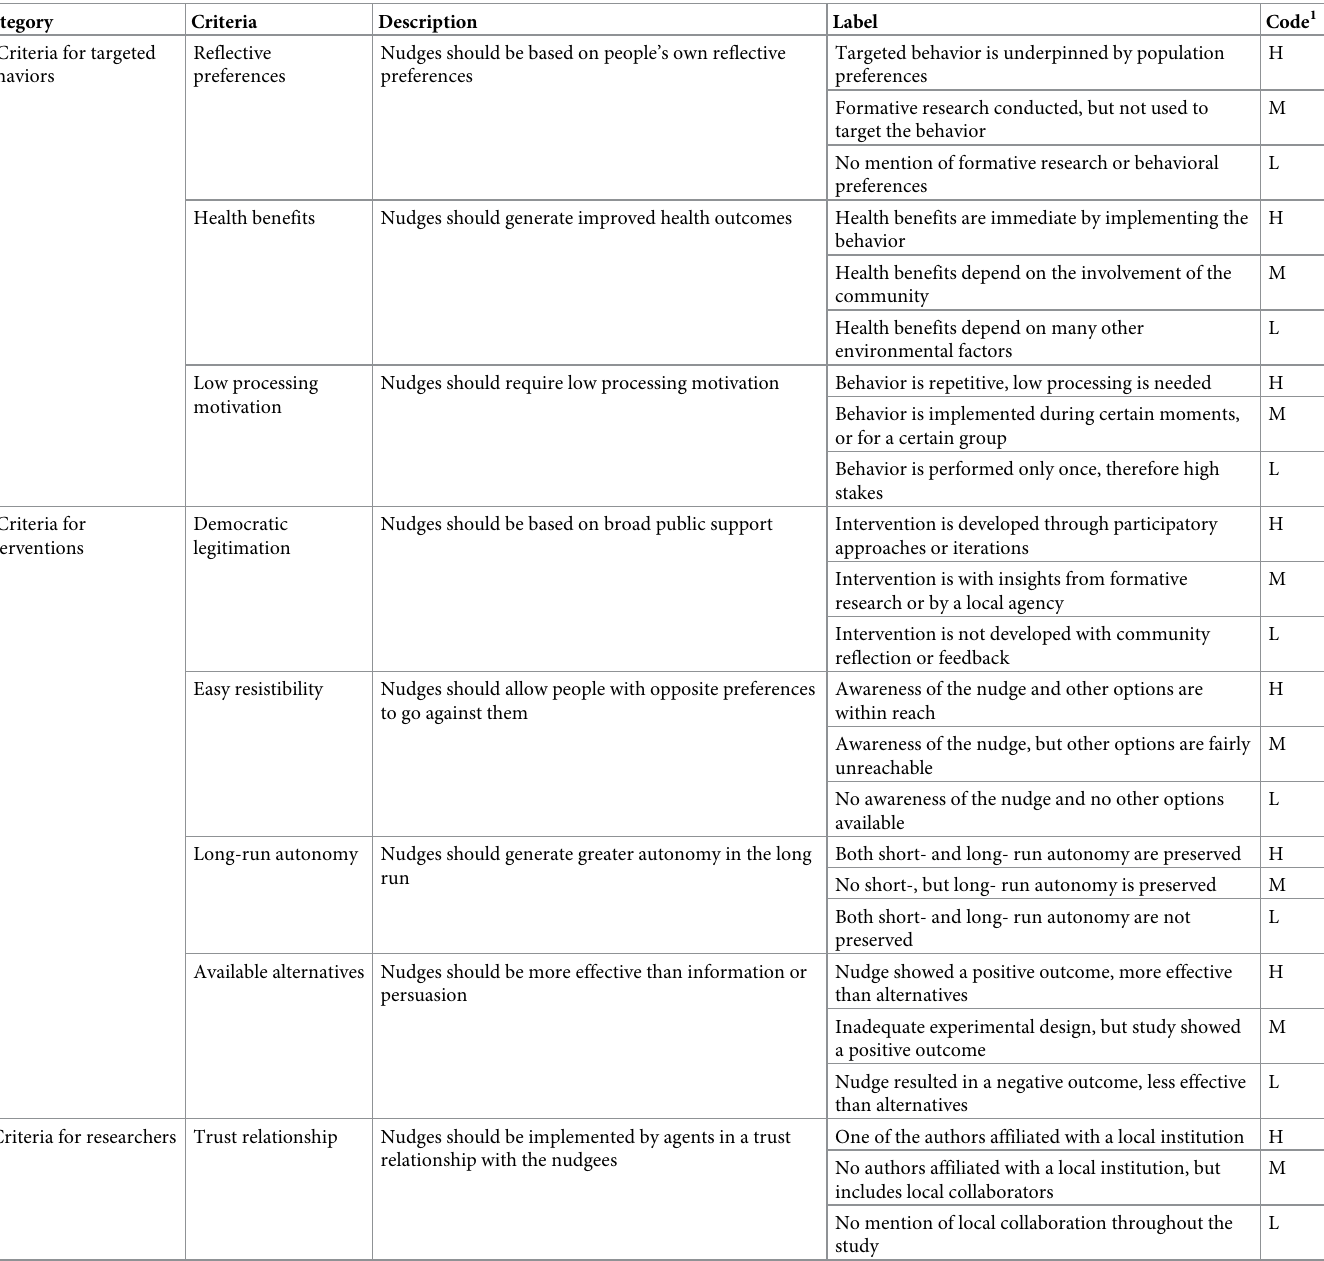
Table 3. Criteria adapted from Engelen (2019) for ethical assessment of nudge strategies targeting health promotion behaviors related to neglected tropical diseases in low- and middle-income